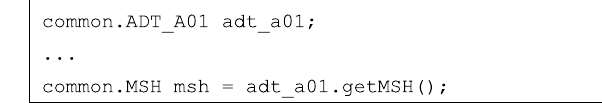
Fig. 4. Example of code using the library based on the proposed